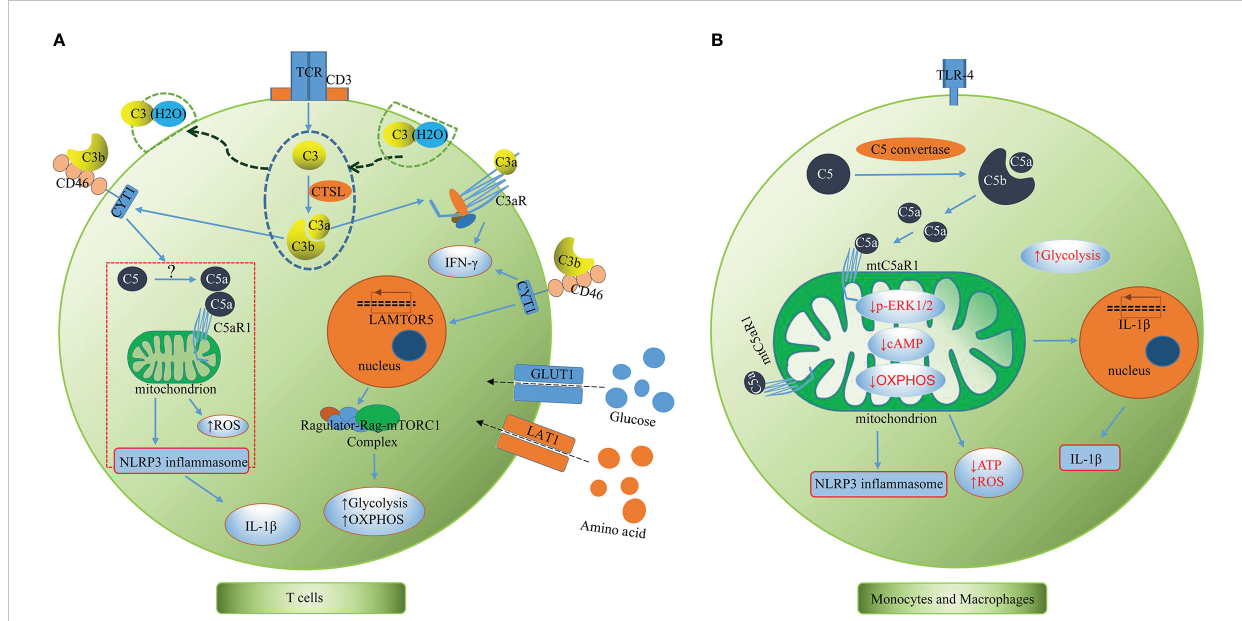
FIGURE 2 The complosome in T cells and monocytes and macrophages. (A) T cells. T cells have intracellular store of C3 (partly taken up from serum as C3 (H2O)), C5 and CTSL. CTSL continuously cleaves intracellular C3 into bioactive C3a and C3b. Upon TCR stimulation, the intracellular C3 and activation fragments C3a, C3b and CTSL translocate to the cell surface where C3a and C3b signal in an autocrine activation though C3aR and CD46, respectively, to to induce Th1 immunity and IFN- g production. The CD46 activation drives expression of LAMTOR5, LAT1 and GLUT1, which promotes mTORC1 activation, nutrient in fl ux, glycolysis, and OXPHOS. CD46 also induces intracellular C5 activation and C5a generation via yet unknown mechanisms. The intracellular C5a interacts with the mitochondrially expressed C5aR1, resulting in mitochondrial ROS production, intrinsic NLRP3 in fl ammasome assembly and activation, maintenance of IFN- g secretion, and subsequent mature IL-1 b secretion during T cell migration into in fl amed tissues. CTSL, cathepsin L; TCR, T cell receptor; LAMTOR5, late endosomal/lysosomal adaptor and MAPK and mTOR activator 5; GLUT1, glucose transporter; LAT1, large neutral amino acid transporter 1; mTOR, mammalian target of rapamycin; OXPHOS, oxidative phosphorylation; ROS, reactive oxygen species. (B) Monocytes and macrophages. Intracellular complement C5 is cleaved and generates C5a via intracellular C5 convertase (C3bBbC3b). C5a/C5aR1 signaling on mitochondrial membranes alters mitochondrial activity, reduces mitochondrial ERK1/2 phosphorylation, cAMP formation and shifts ATP production via reverse electron chain fl ux toward ROS production and aerobic glycolysis, promoting IL-1 b gene expression and processing of bioactive Il-1 b upon DAMP sensing. cAMP, Cyclic Adenosine monophosphate; ATP, adenosine triphosphate; ROS, reactive oxygen species; DAMP, damage-associated molecular